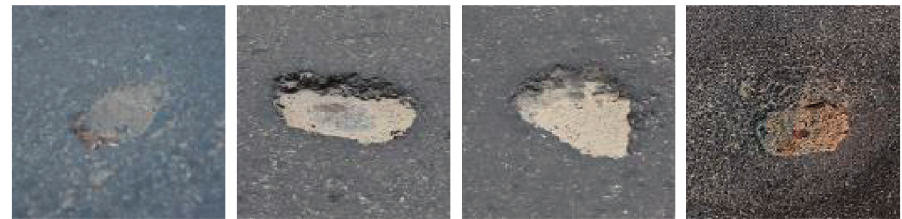
Figure 1: Appearances of potholes in the asphalt pavement surface.